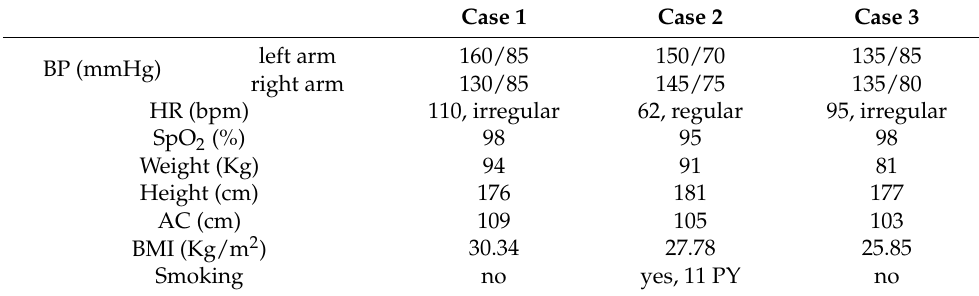
Table 1. Overview of the physiological parameters of the three patients at the first presentation.